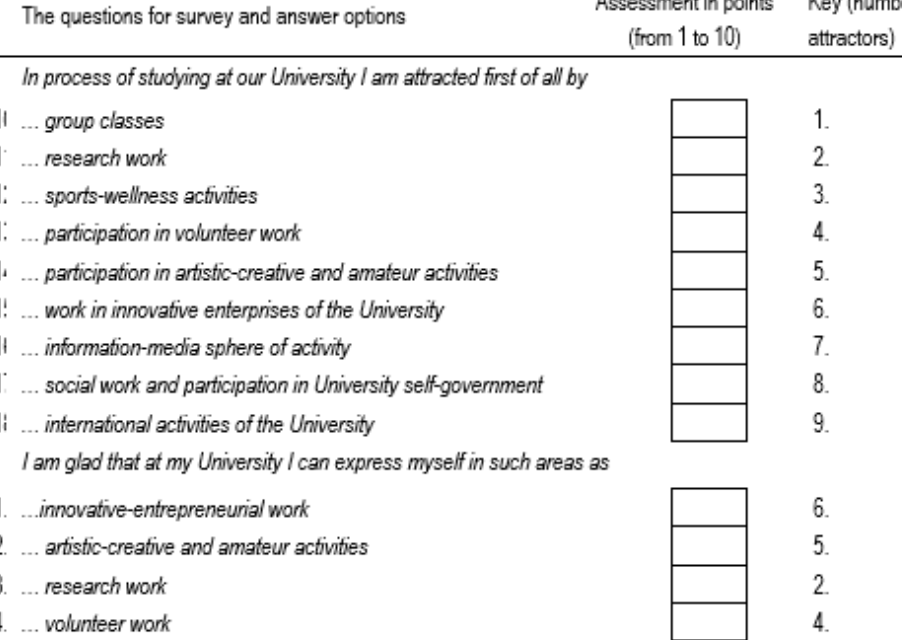
Stimulus material of the method for assessing the subjective significance of areas of intra-university